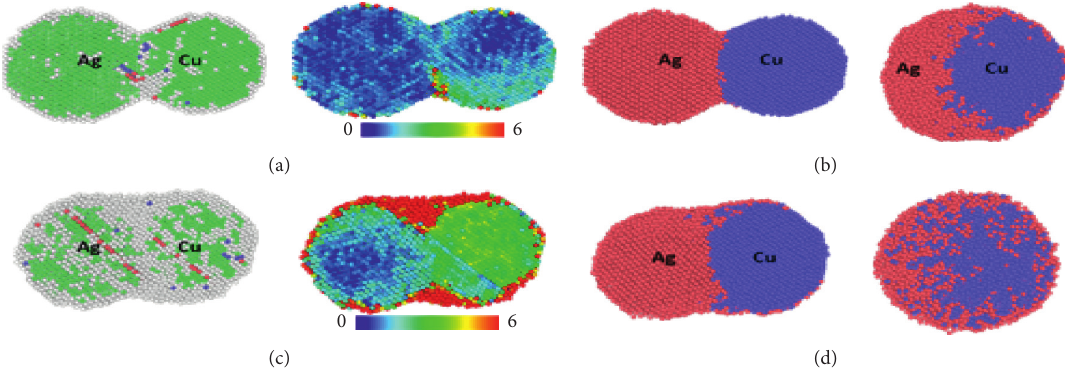
Figure 5: Cross section of CuAg-6nm. (Green atoms, red atoms, white atoms are FCC structure, HCP structure, disorder structure,